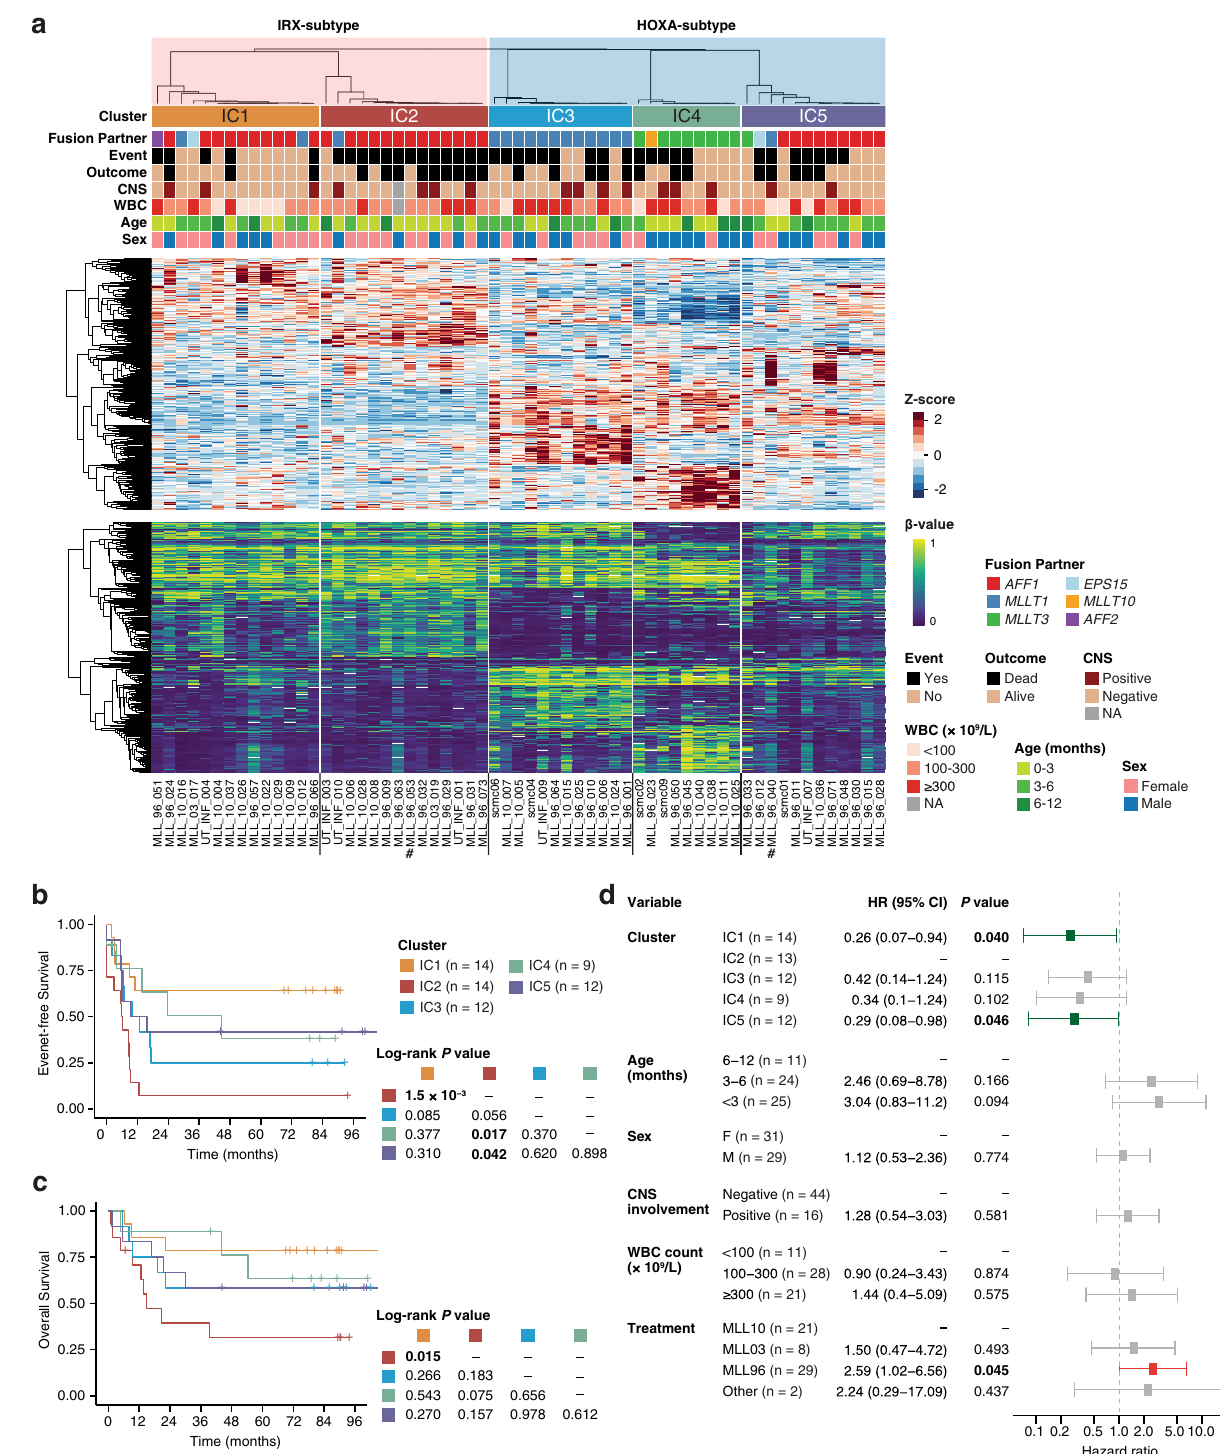
Fig. 1 | Dual-omics-integrative clustering of KMT2A -r infant ALL. a Comprehensive dual-omics heatmaps of KMT2A -r infant ALL. Top: clin- icopathological features of the discovery cohort of 61 infants. The dendrogram is from consensus clustering and indicates sample-to-sample distances. Middle: Expression heatmap of cluster marker genes. The top 100 signi fi cantly up- or downregulated marker genes for each of the fi ve ICs were included. Bottom: Methylation heatmapof cluster marker probes. The top100signi fi cantlyhyper-or hypomethylated marker probes for each of the fi ve ICs were included. Number signs (#) indicate the twocases with B/M MPAL. CNScentral nervous system, WBC